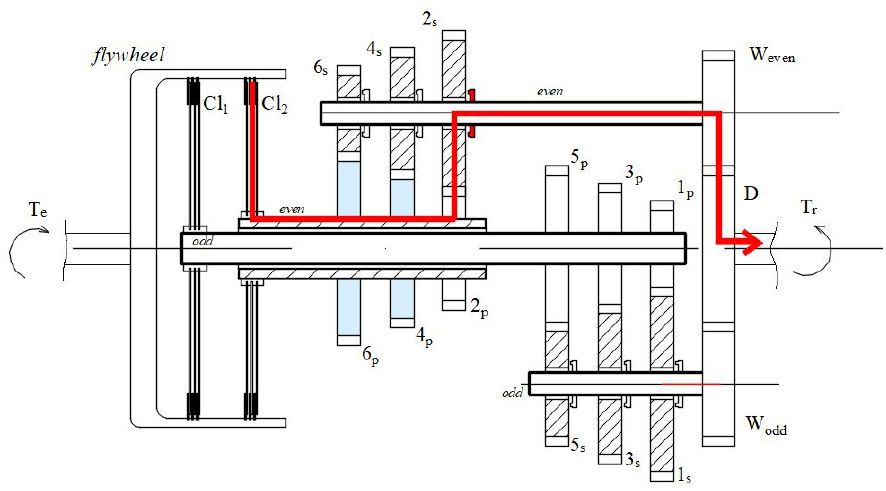
Figure 7. The DCT gear shifting transient: Cl 2 engaged with 2nd gear in running